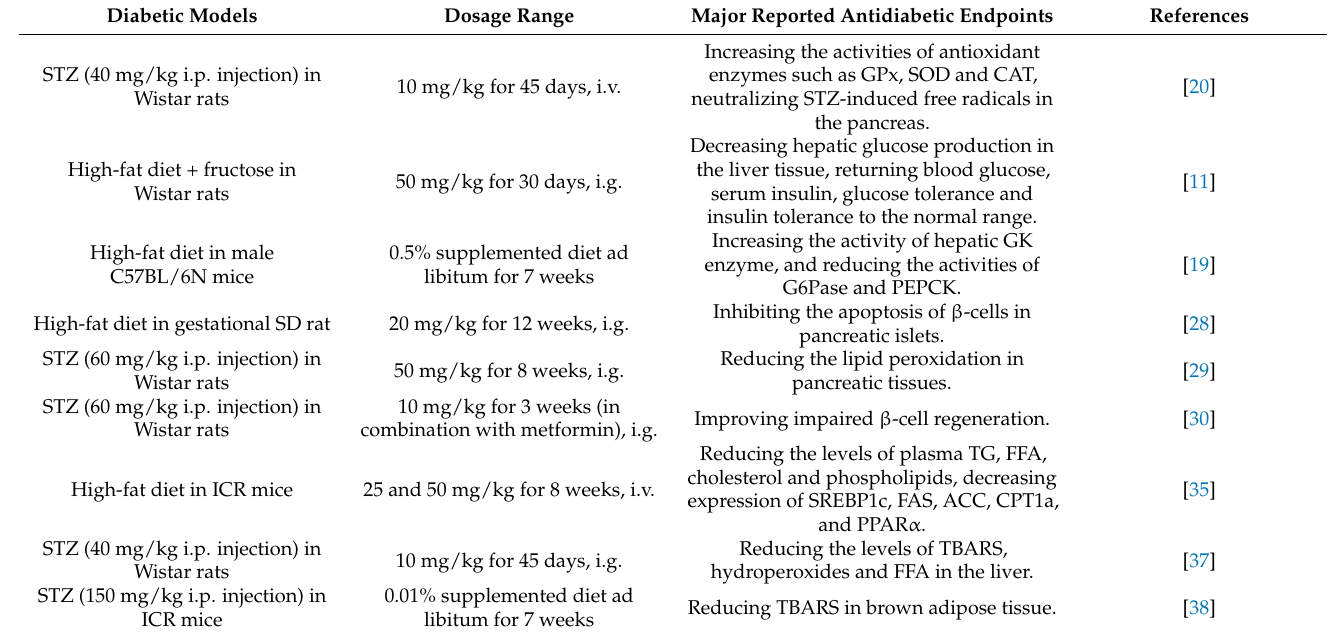
Table 1. Major effects of FA on diabetes